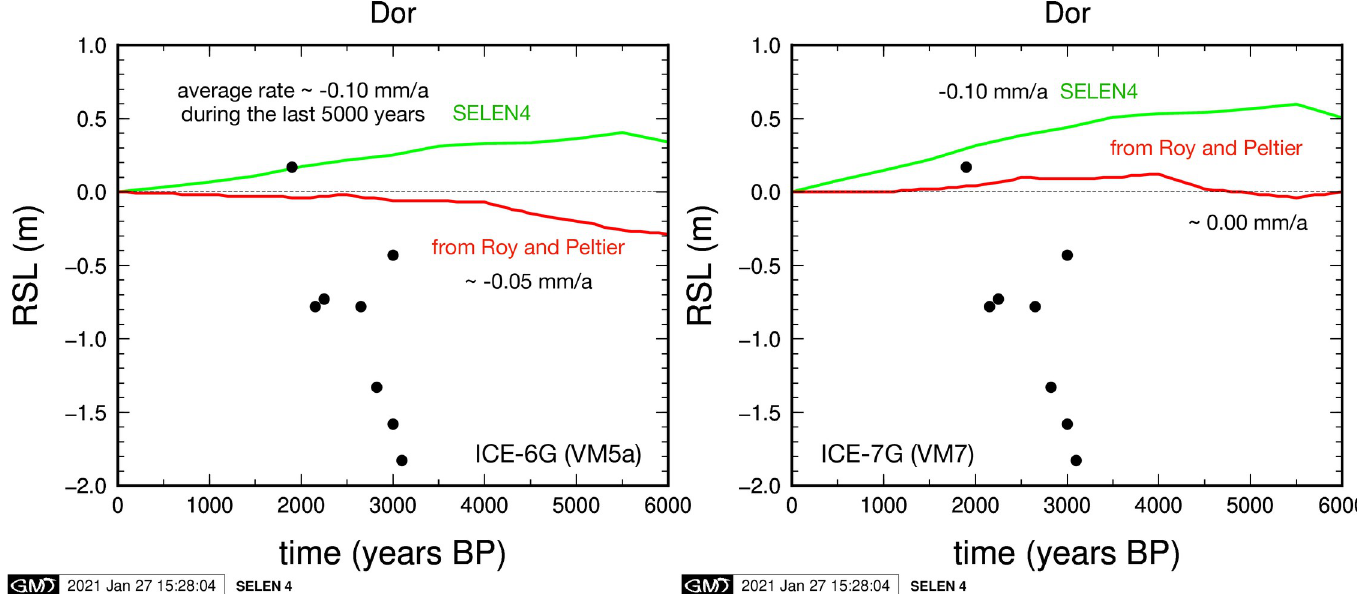
Fig 7. Synthetic RSL reconstructions at the site of Dor according to the ICE-6G (left) and ICE-7G (right) GIA models. Each panel shows results obtained with the SELEN4 program by GS (in green) and those using the parameters used in Roy and Peltier [38] red, which were provided by WR Peltier for the current study. In both cases, the models are not in agreement with RSL observations at the Dor site, represented by black circles (see Table 1).